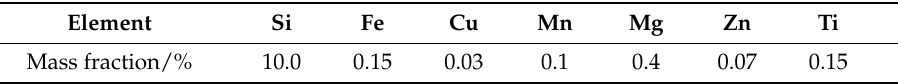
Table 2. Parameters of aluminum–silicon matrix.